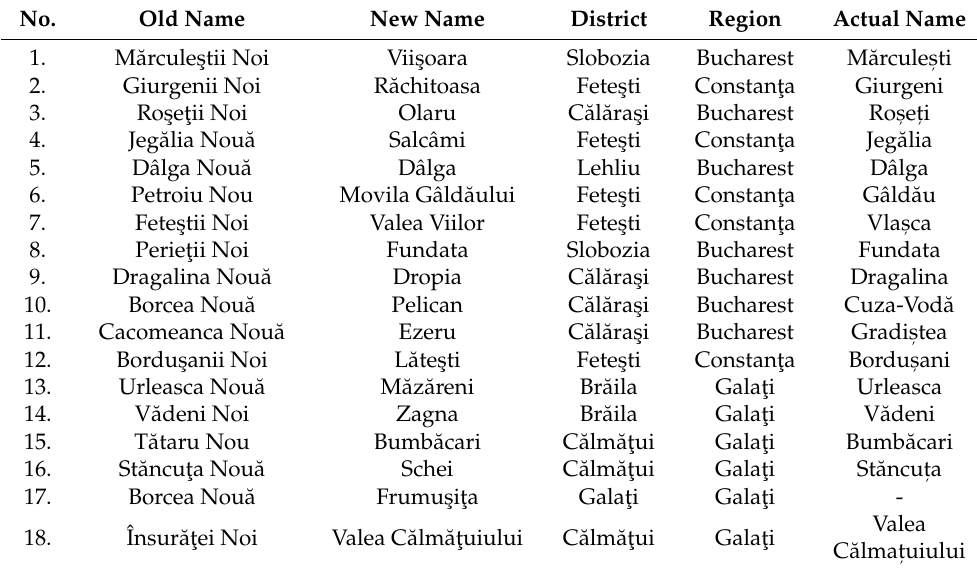
Table 2. Settlements established following mass deportations to the Central B ă r ă gan Plain.